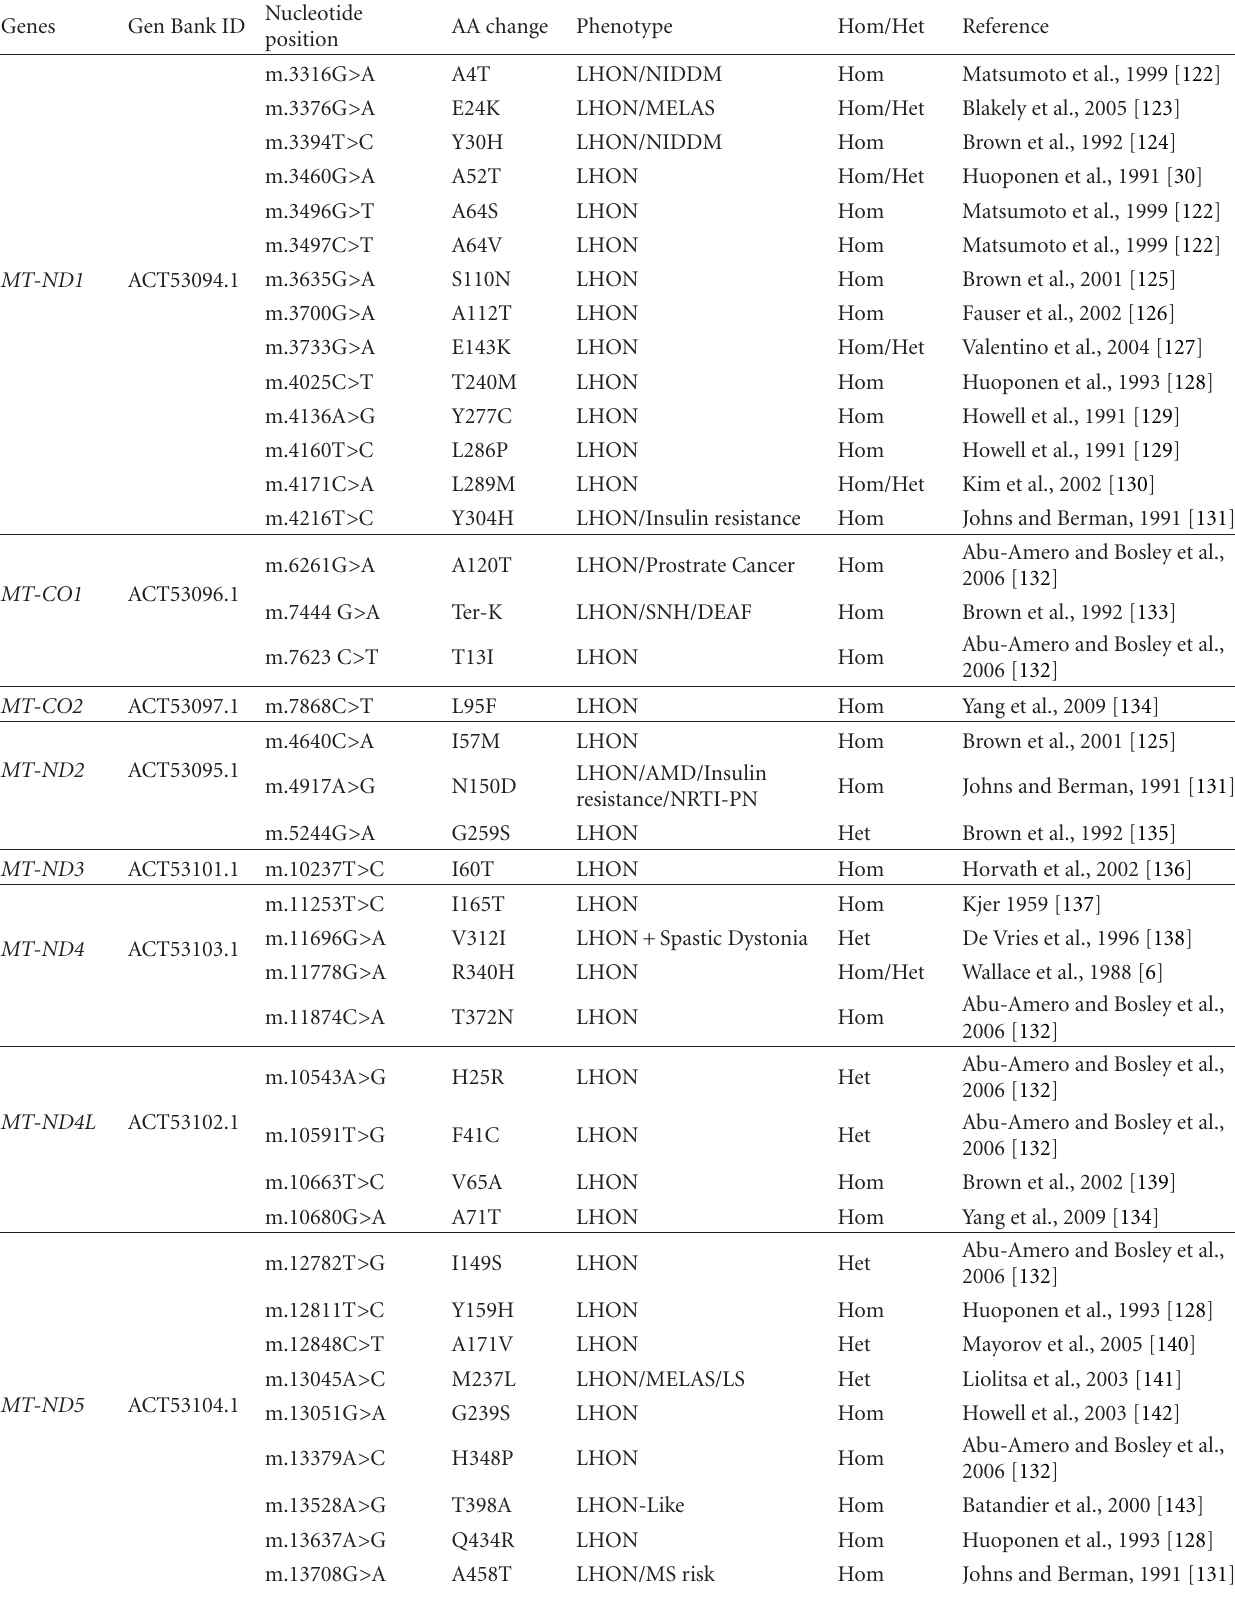
Table 1: Comprehensive list of genes/mutations involved in